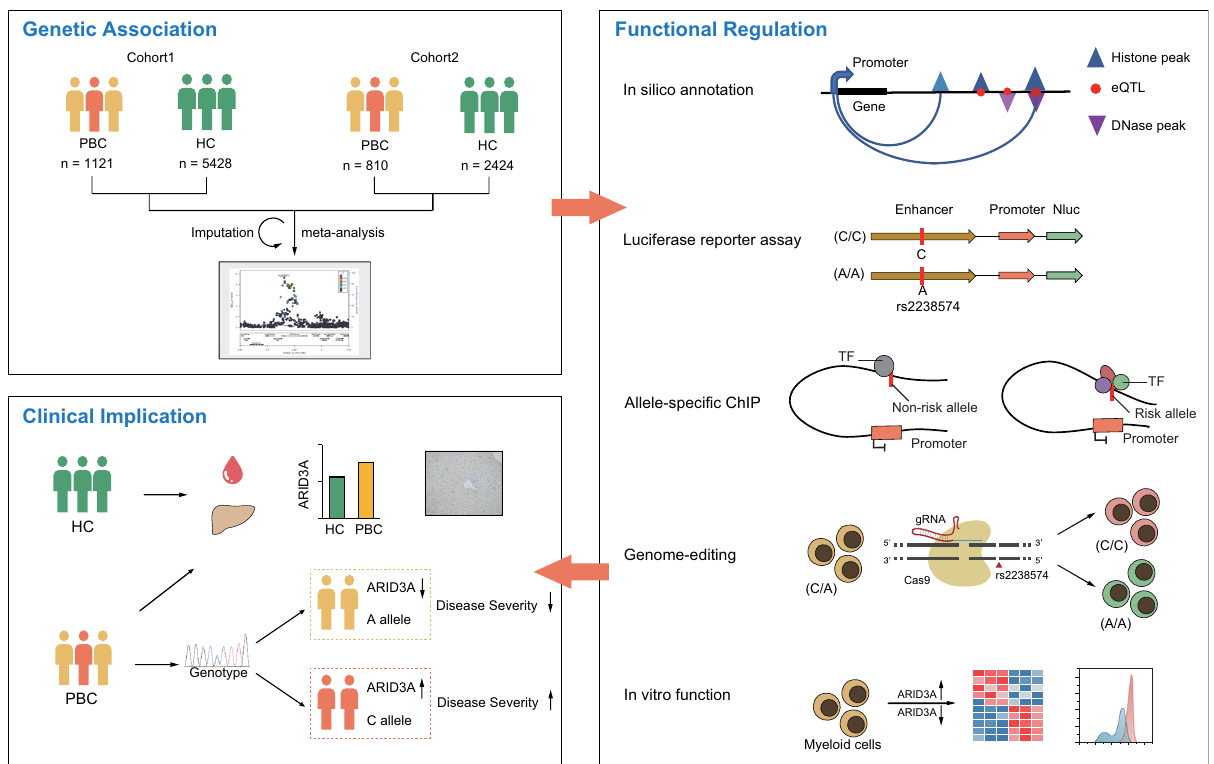
Fig. 8 | Graphicalrepresentation of theregulation and function of19p13.3 in PBC. HChealthy control,ChIP chromatin immunoprecipitation, TF